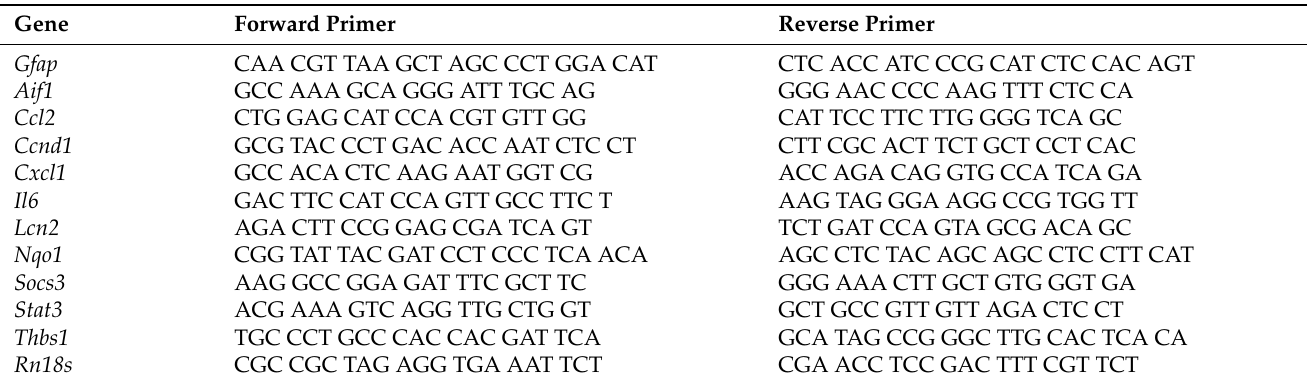
Table 1. Primer sets for quantitative